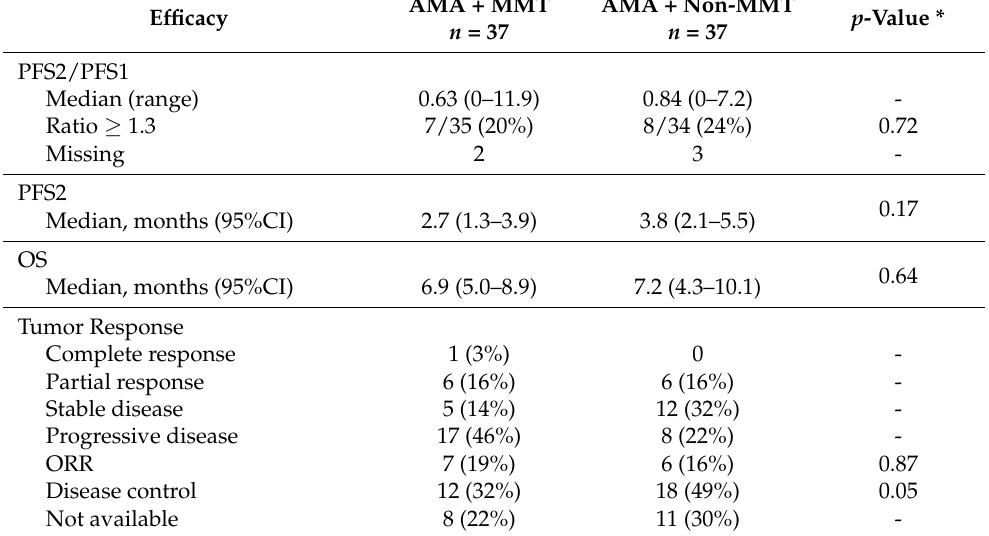
Table 3. Efficacy